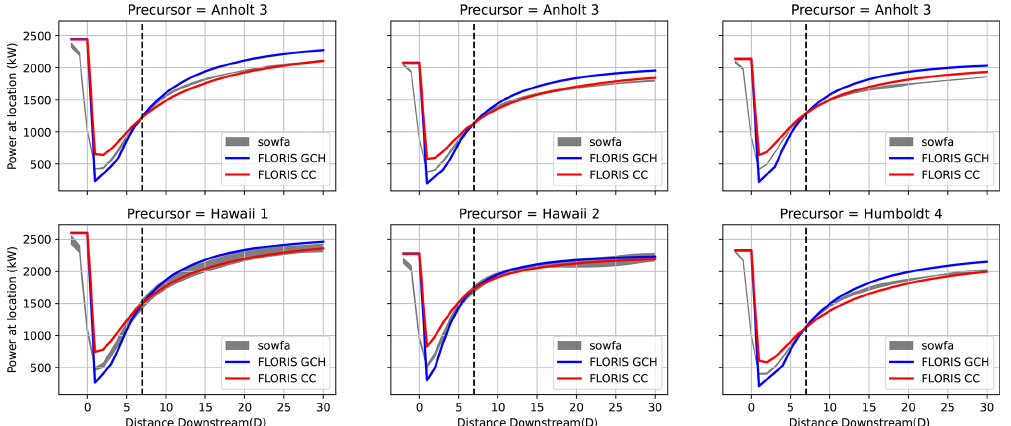
Figure 1. Power production of a downstream wind turbine located at various distances behind a yaw-aligned upstream wind turbine for each precursor described in Table 2. The TI values for both the GCH and CC models were selected to match the wake depth in SOWFA at 7 D distance (indicated via a dashed line). Note that empirical results have shown that the GCH model typically overpredicts recovery for distances > 10 D (Doekemeijer et al., 2022).